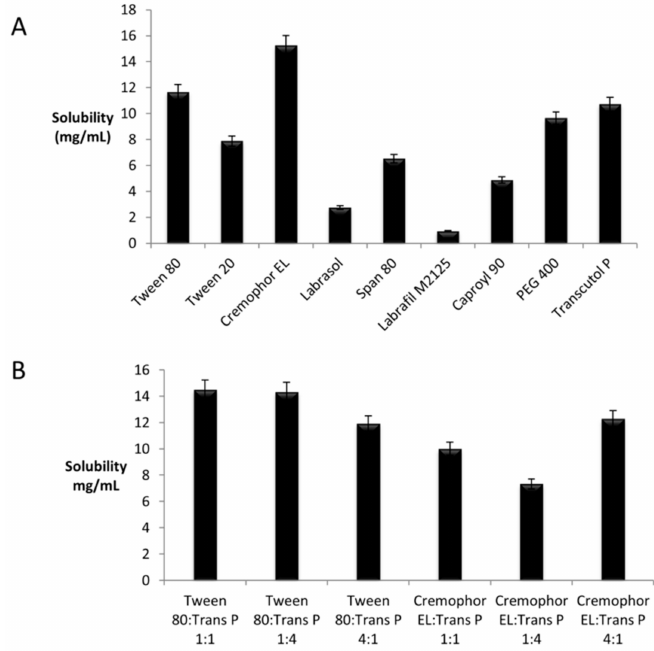
Figure 1. Saturation solubility of α -linolenic acid in different surfactant ( A ) and different ratios of surfactants blends ( B ). Mean ± SD, n =